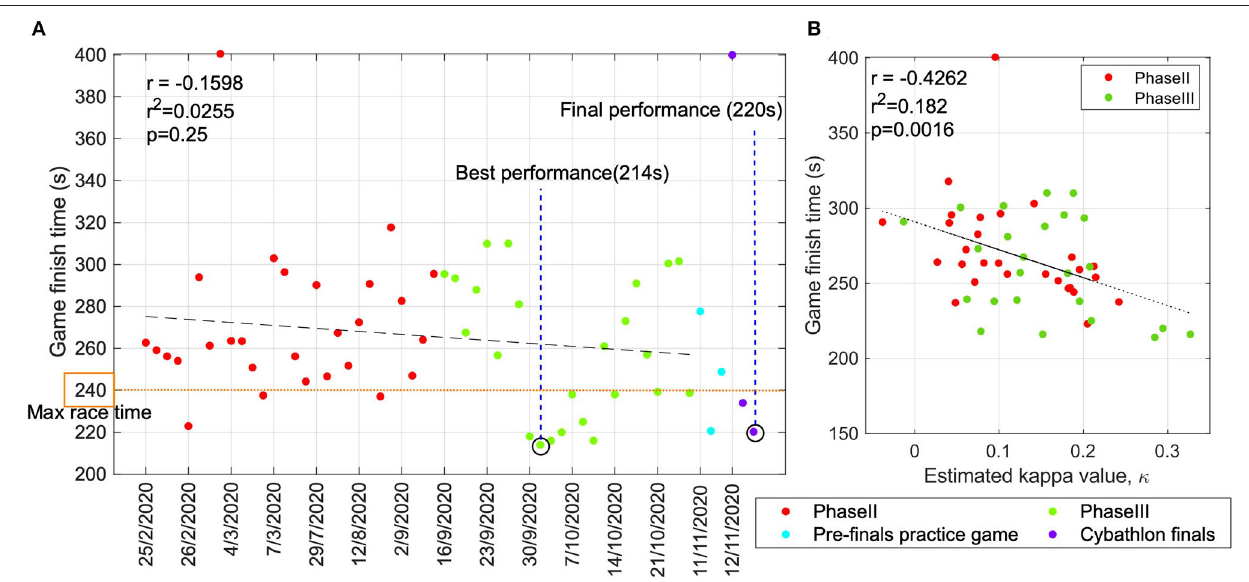
FIGURE 4 | Performance of the pilot across the training period and Cybathlon. (A) Cybathlon BCI race required the pilot to navigate a virtual distance of 500 m in under 240 s. The game finish time, τ finish achieved by the pilot throughout the training is shown in this figure. The black dashed line indicates the linear fit and the qualifying time is indicated by the horizontal orange dashed line. The performances in phase II, phase III, pre-finals, and final Cybathlon race are indicated by red, green, blue, and purple markers, respectively. (B) The relationship between performance metrics κ and τ finish across the training phases II and III. Sessions with higher decoding performance, κ record shorter race finish time, τ finish . The black dashed line shows the linear fit and the significant p = 0.0016 inverse relation between the two